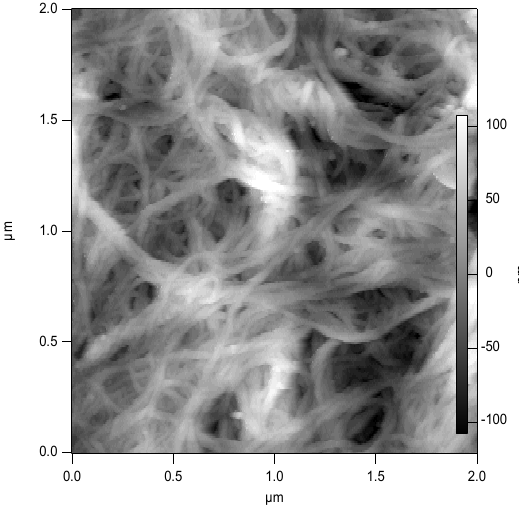
Figure 1. AFM image recorded for ensemble of SWCNT dispersed randomly on a silicon